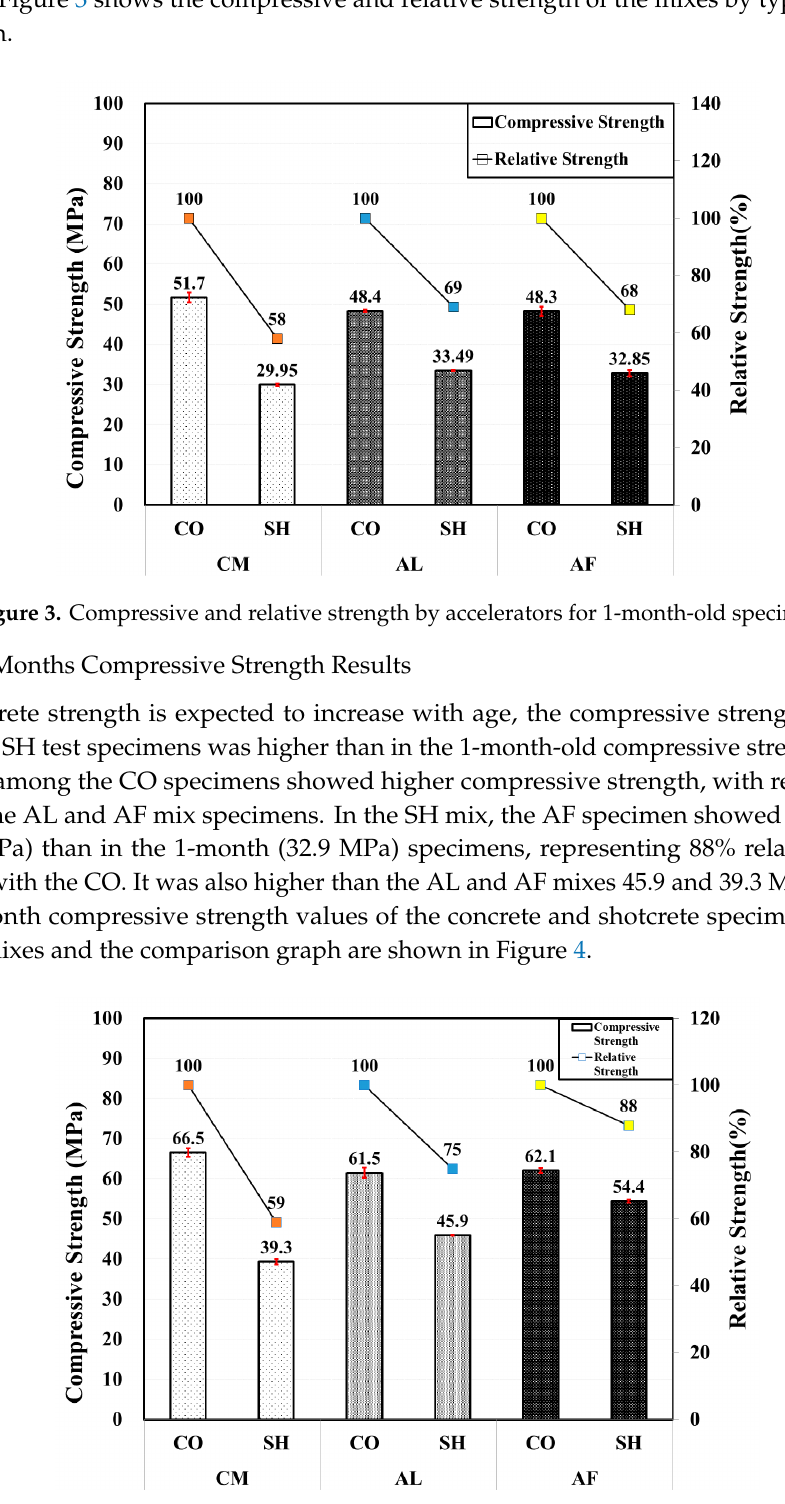
Figure 4. Compressive and relative strength by accelerators for 3-month-old specimens.